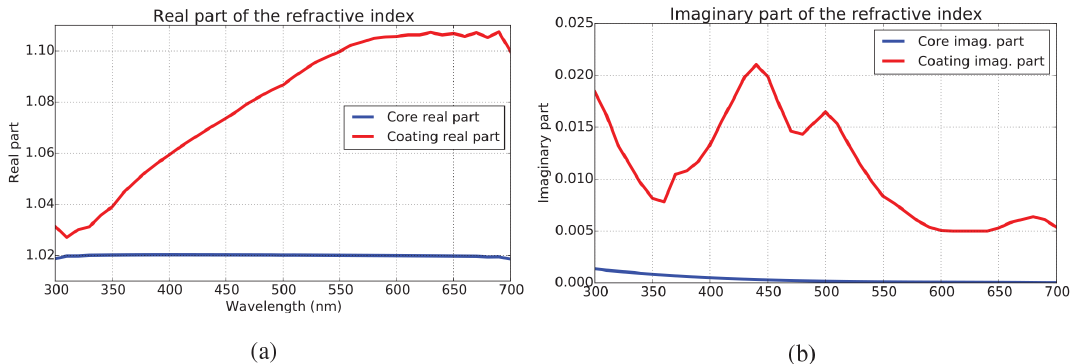
Figure 16. Inner and outer (a) real and (b) imaginary parts of the refractive indices using the Bernard model combined with the genetic algorithm for cylindrical-shaped particles.